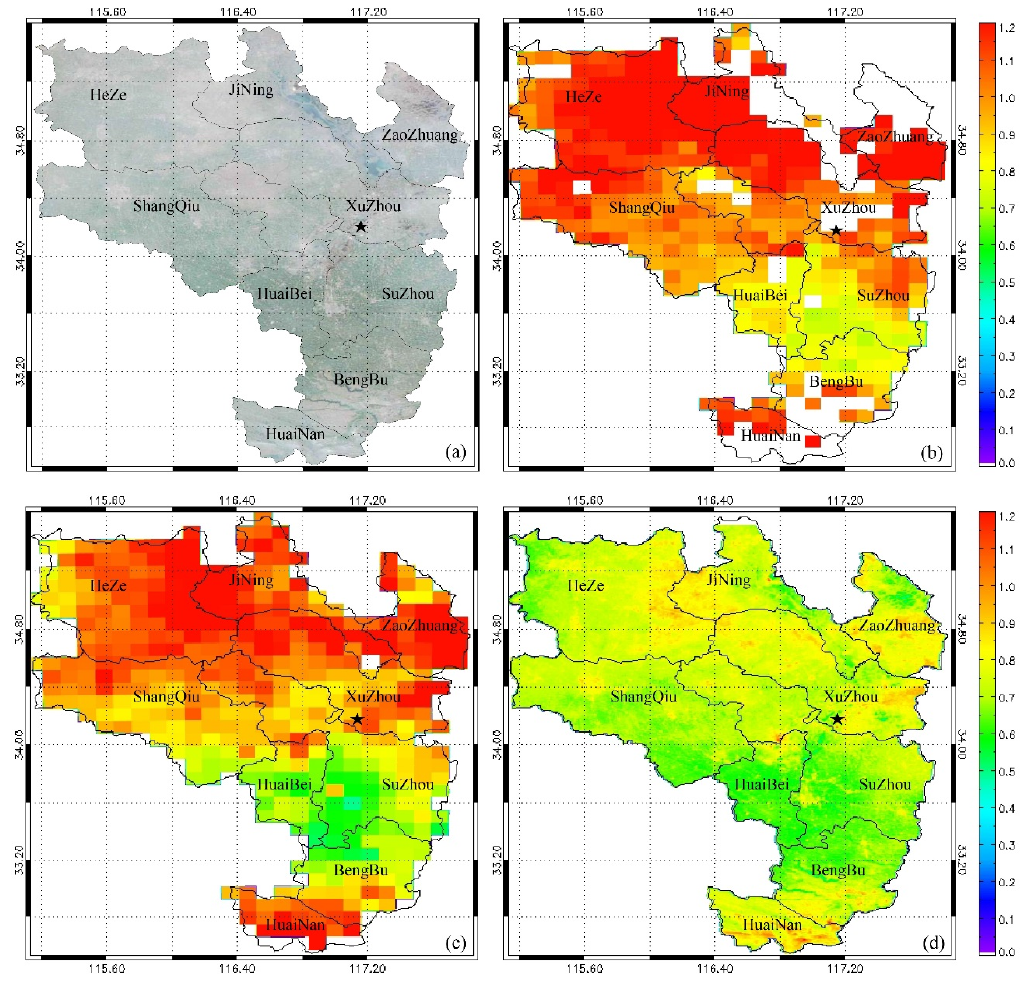
Figure 6. Contrast of satellite-derived AOD results in the study region on 13 February 2015. ( a ) True color (RGB:143); ( b ) Aqua DT AOD at 10 km; ( c ) Aqua DB AOD at 10 km; ( d ) Aqua SARA AOD at 500 m.